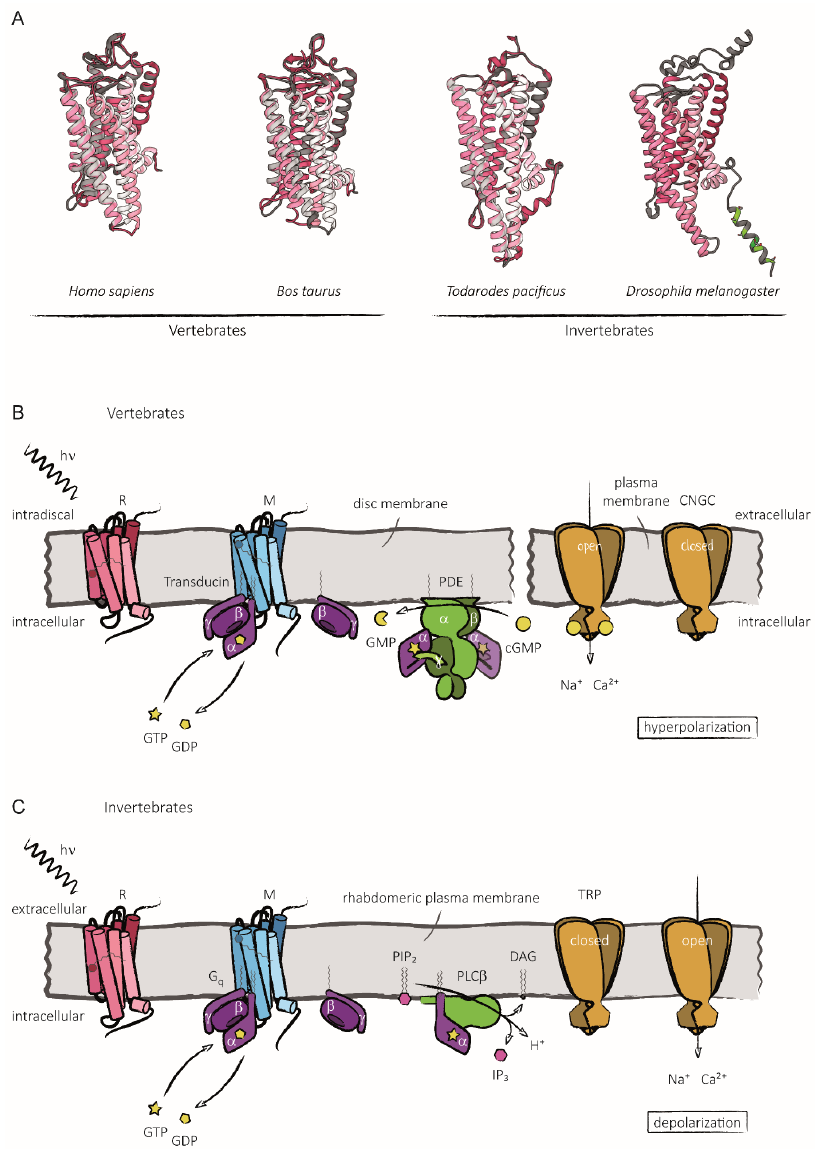
Figure 1. Schematic representation of phototransduction cascades in vertebrates and invertebrates. ( A ) Rhodopsin proteins as ribbon models in shades of fuchsia from Homo sapiens (human), Bos taurus (cattle), Todarodes pacificus (squid) and Drosophila melanogaster (fruit fly) based on structural predictions from AlphaFold DB [20]. Predicted structures of squid, cattle and human are aligned with published X-ray crystal structures 2Z73 [21], 3C9L [22] and 4ZWJ [23] from RCSB PDB [24], respectively, dis- played in shades of gray to visualize AlphaFold’s accuracy. Protein crystal structures commonly omit rhodopsin’s flexible C-terminus which has thus been cropped from the corresponding models predicted by AlphaFold as well. The C-terminus of AlphaFold’s Drosophila prediction is included despite low confidence to illustrate phosphorylatable serine (light green) and threonine (dark green) residues as a ball and stick representation. ( B ) Exemplarily depicted is the phototransduction cascade in the rod cells of humans. In the disc membrane, photon absorption results in the transformation of opsin-bound 11- cis -retinal to all- trans -retinal and subsequently the conversion from rhodopsin (R) (fuchsia) to metarhodopsin (M) (blue). M interacts with the heterotrimeric G protein (transducin) (pur- ple), promoting the exchange of GDP (yellow pentagon) for GTP (yellow star) within the α subunit (G α ). G α -GTP is separated from the βγ subunits of transducin and binds to phosphodiesterase (PDE) (green) whereupon it partially retracts the catalysis-inhibiting γ subunit of PDE. Thusly activated by G α -GTP, PDE catalyzes the hydrolysis of cGMP (yellow circle) to GMP (yellow major sector), reducing the local cGMP concentration. The decrease in cGMP levels leads to its disengagement